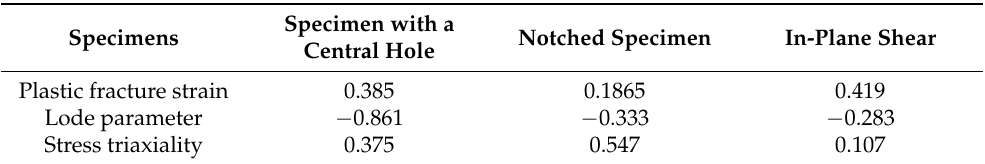
Table 5. Equivalent fracture strains of specimens, average stress triaxiality and lode parameters of different shaped specimens along